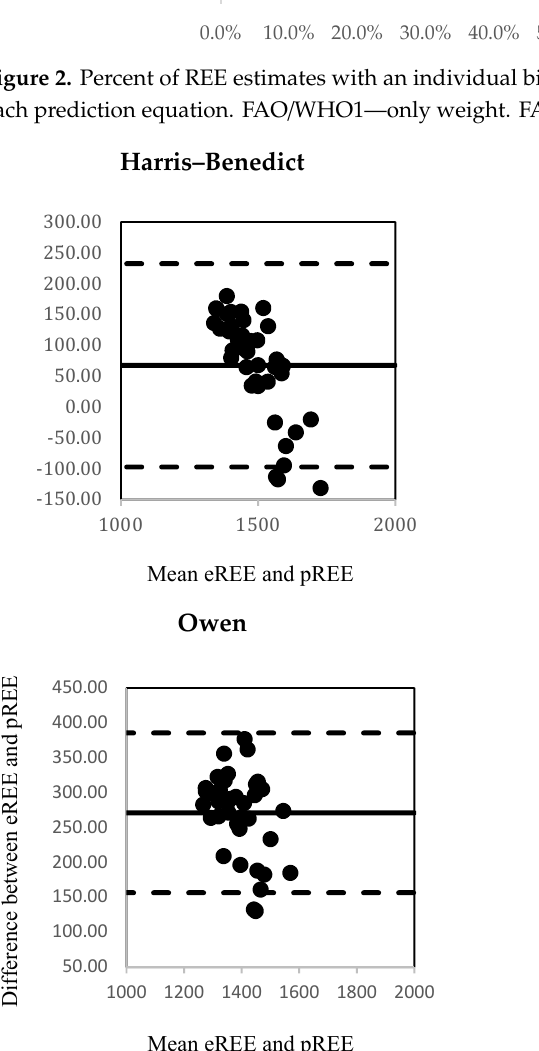
Figure 2. Percent of REE estimates with an individual bias (%) within ± 10% of the estimated REE for each prediction equation. FAO/WHO1—only weight. FAO/WHO2—including weight and height. The correlation between eREE and pREE using the Bland-Altman method is shown in Figure 3.